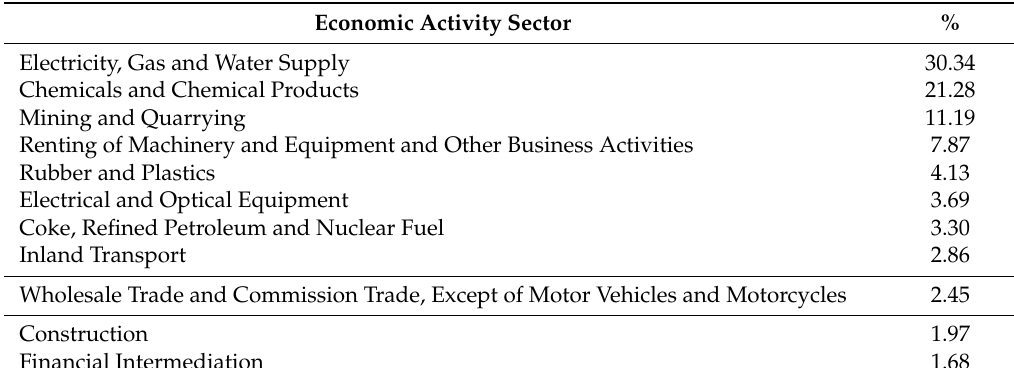
Table 2. Top ten economic activity sectors stimulated by the life cycle of the Energy Storage System, expressed in percentage of the total M€ generated.